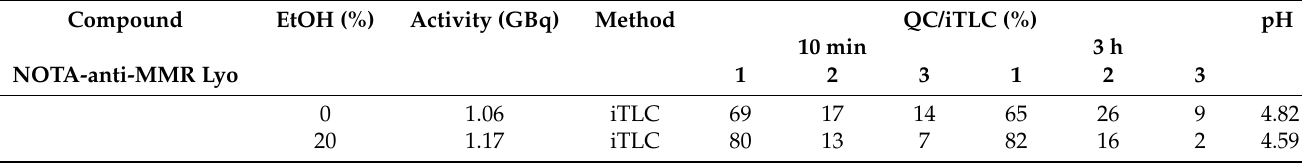
Table 3. Effect of EtOH on radiolysis during high activity 68Ga labeling of lyophilized NOTA-sdAb. Compound EtOH (%) Activity (GBq) Method QC/iTLC (%) pH 10 min 3 h NOTA-anti-MMR Lyo 1 2 3 1